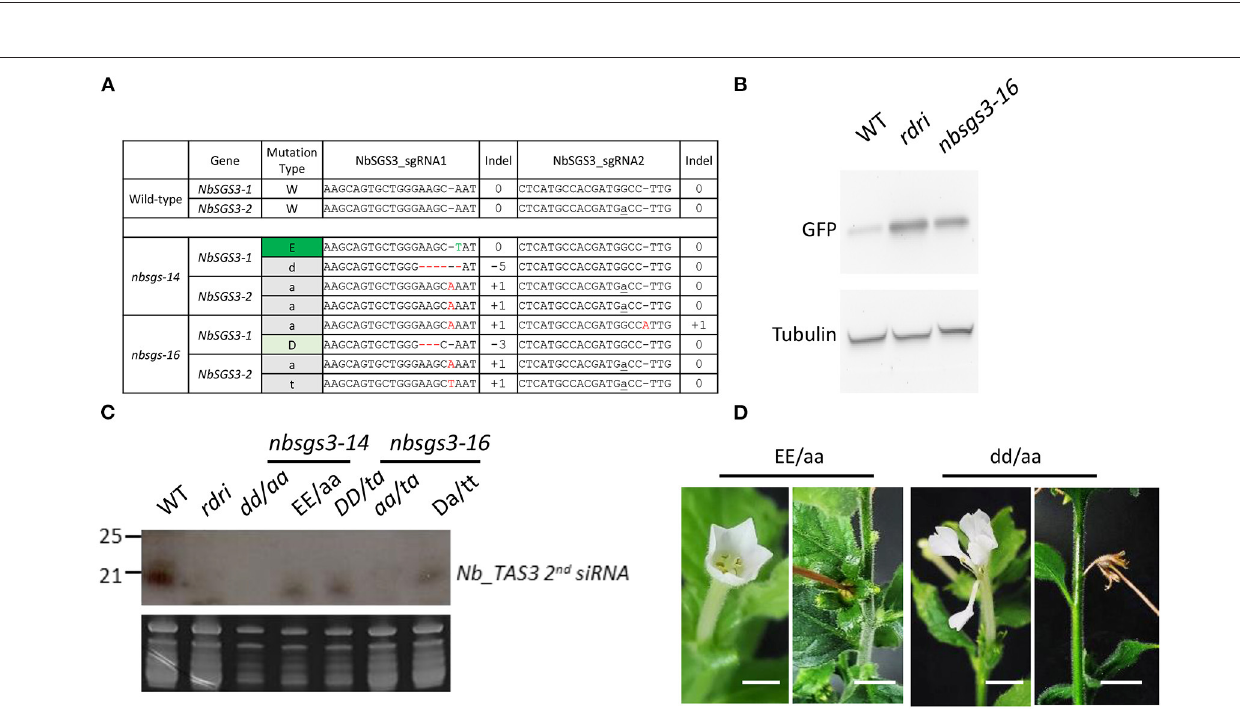
Frontiers in Genome Editing |